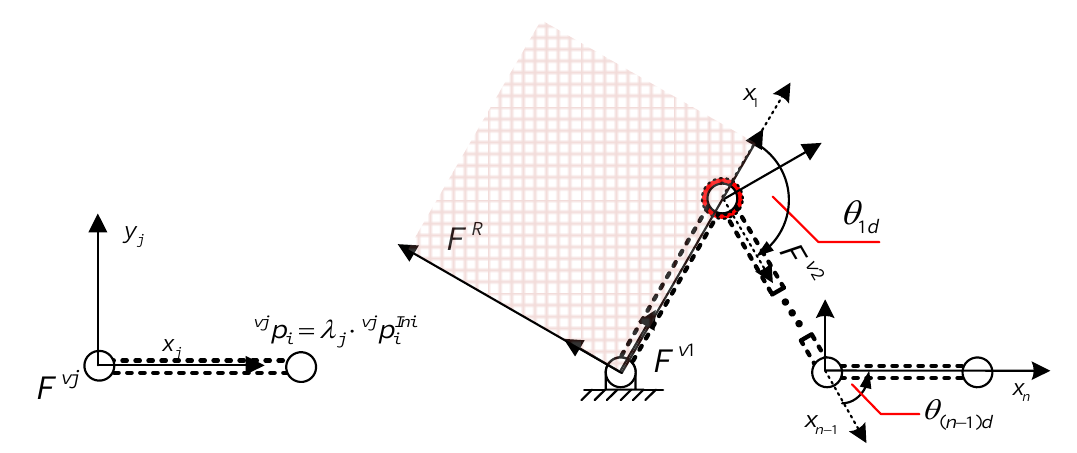
Figure 5. Geometry definition of the virtual linkage.